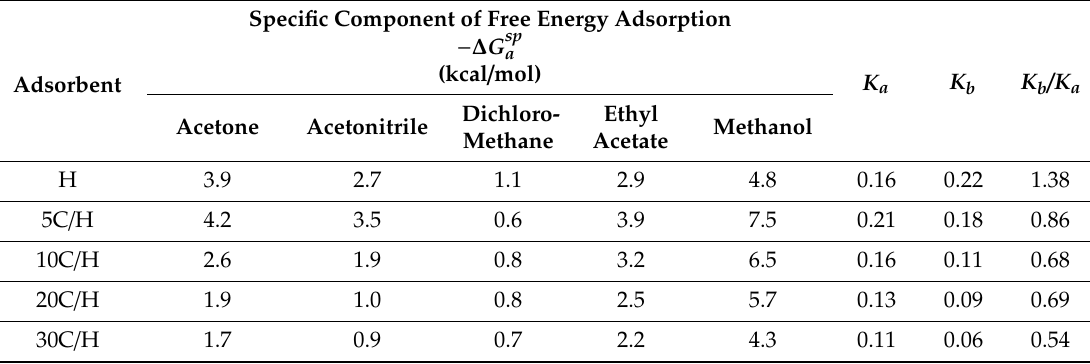
Table 4. Surface properties of carbon-halloysite